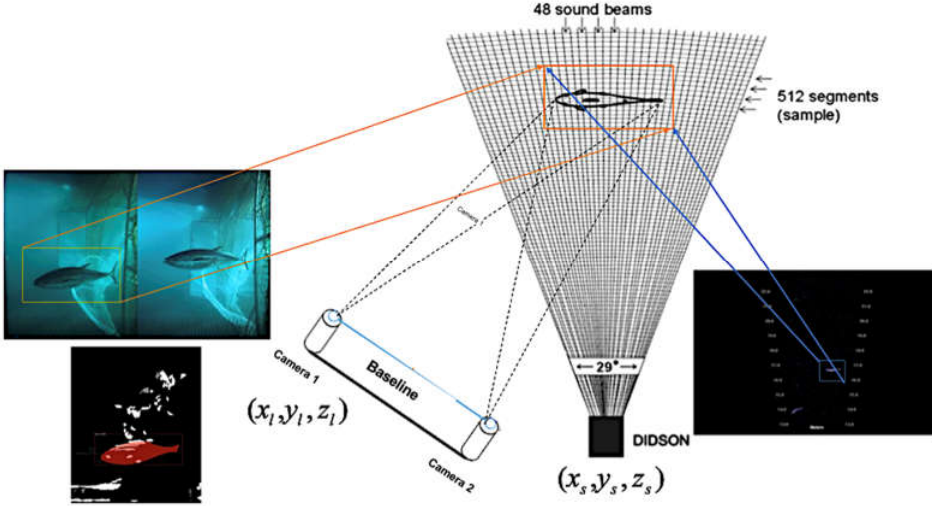
Figure 7. The sensor fusion consists of a stereo camera, and a sonar imaging device captures the fish images from a pond or a net cage. The 3D point clouds of the common object in the left image and the sonar image can be used to calculate the transformation matrix using a 3D affine transformation algorithm [54].